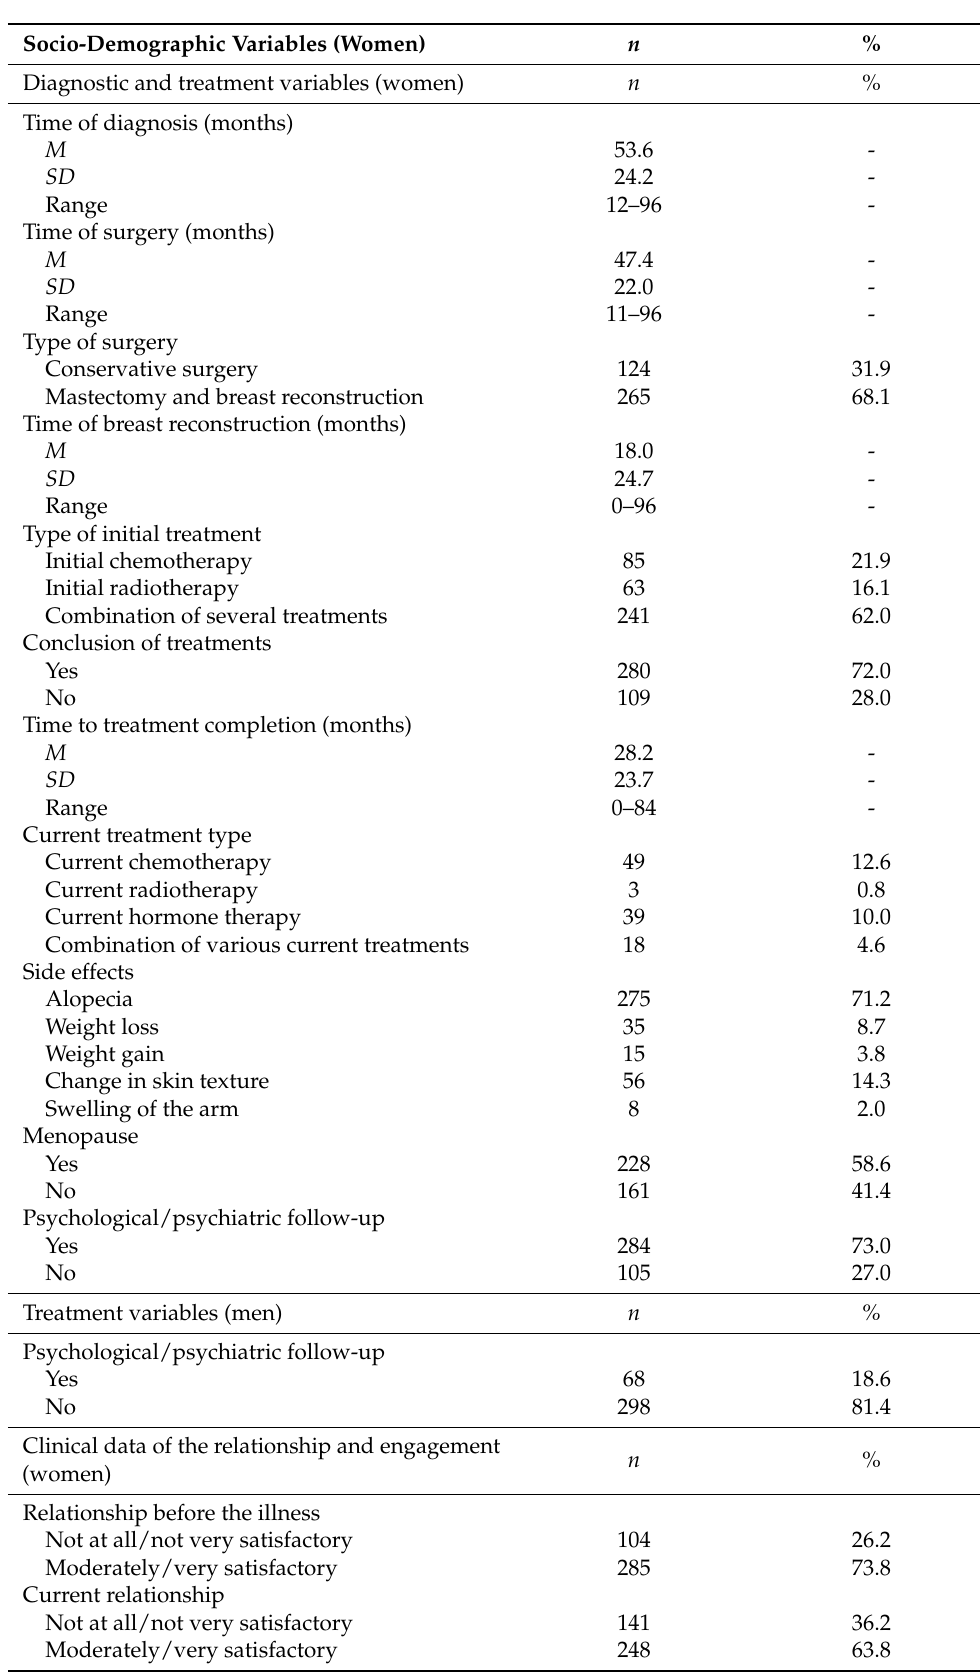
Table 1. Cont . Socio-Demographic Variables